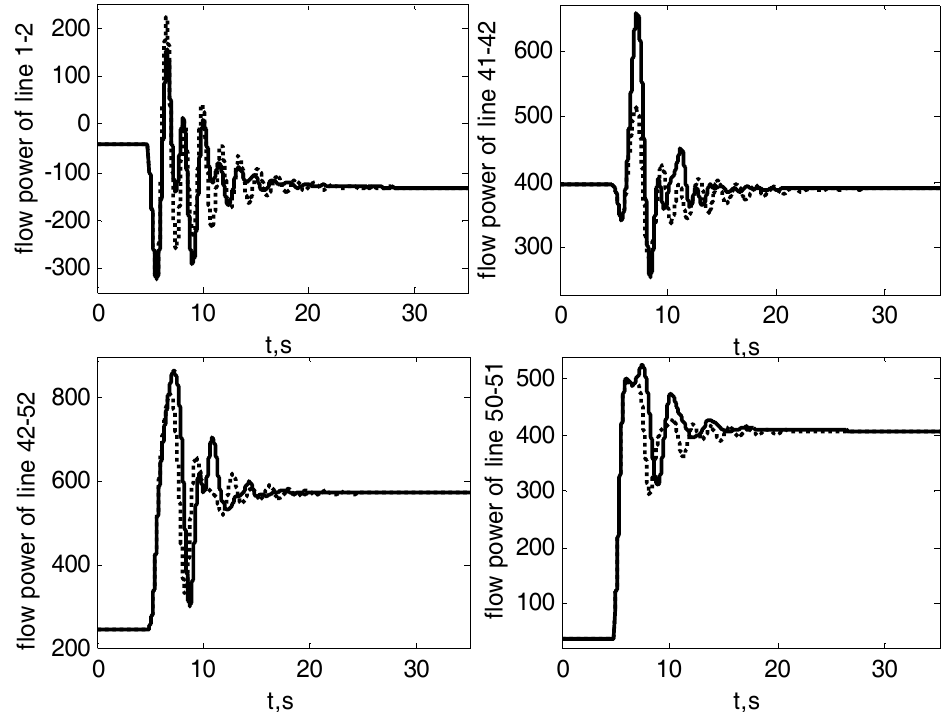
Figure 12. Dynamic responses in case of changing wind power outputs.